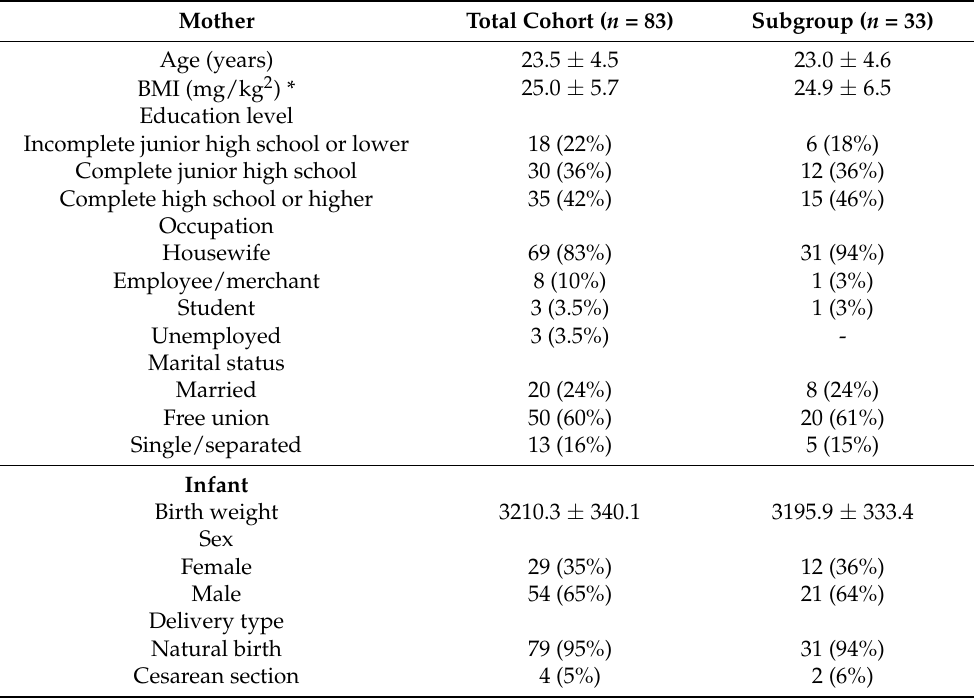
Table 1. Sociodemographic characteristics of the mother–child